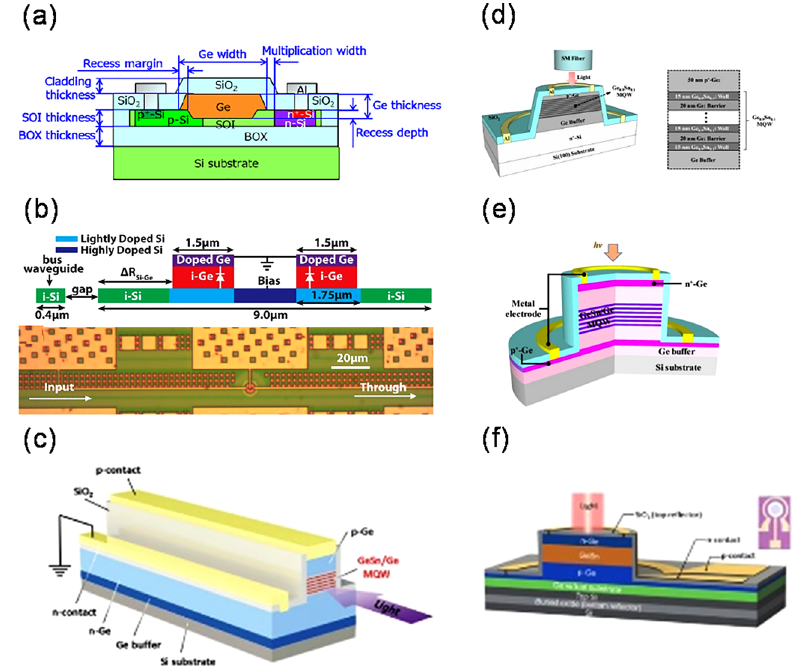
Figure 9: Si – Ge photodetectors for extended spectral